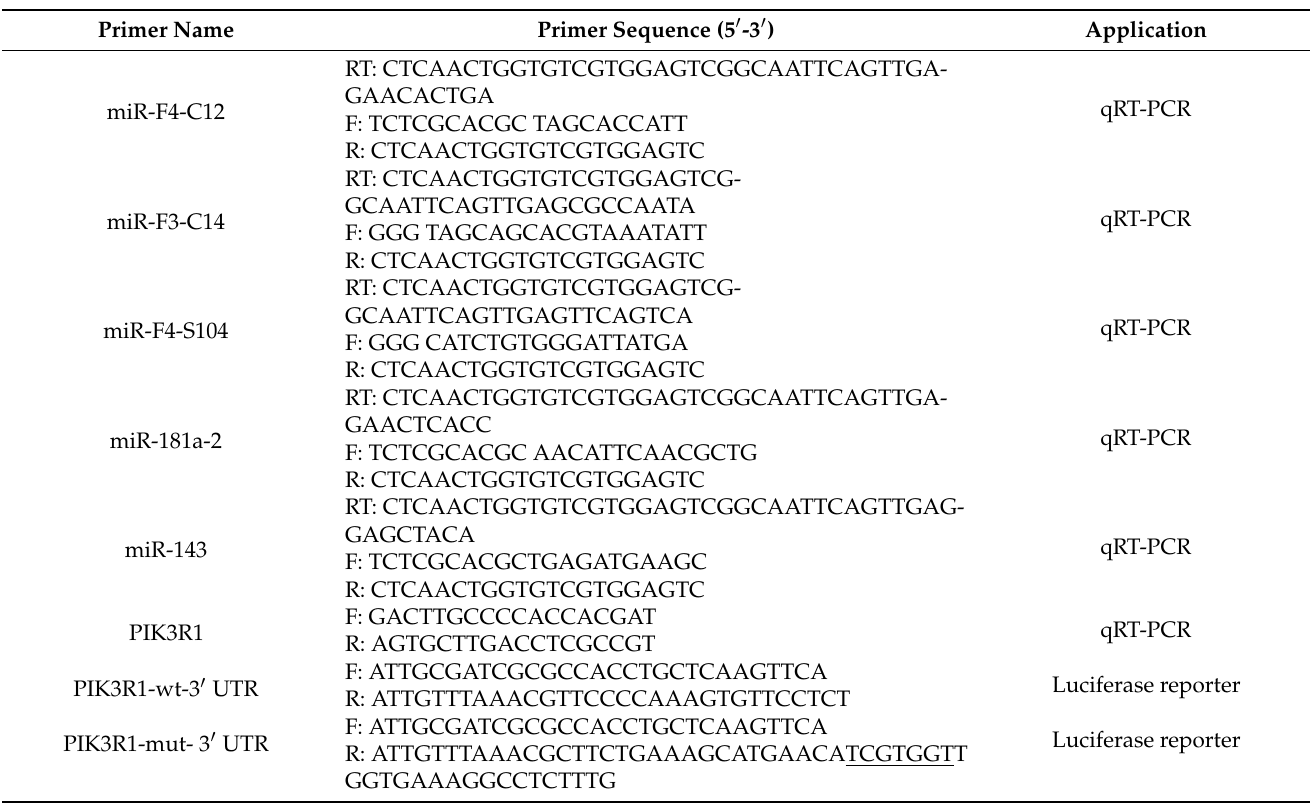
Table 1. The sequence of the primers used in this study. RT: reverse transcription primer. The underlined sequence was the mutation